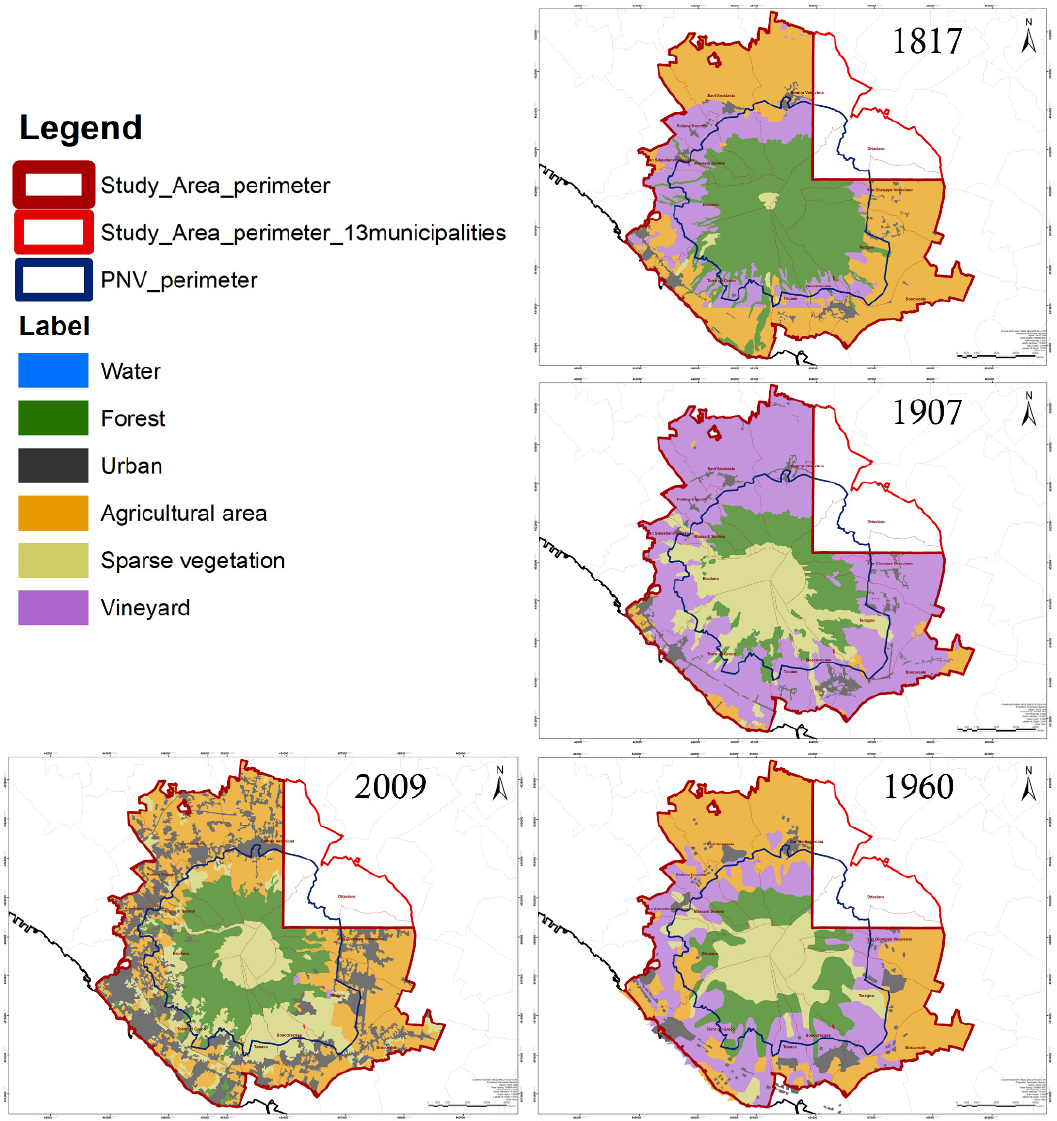
Figure 5. Land use maps of the time steps 1817–1907–1960–2009.